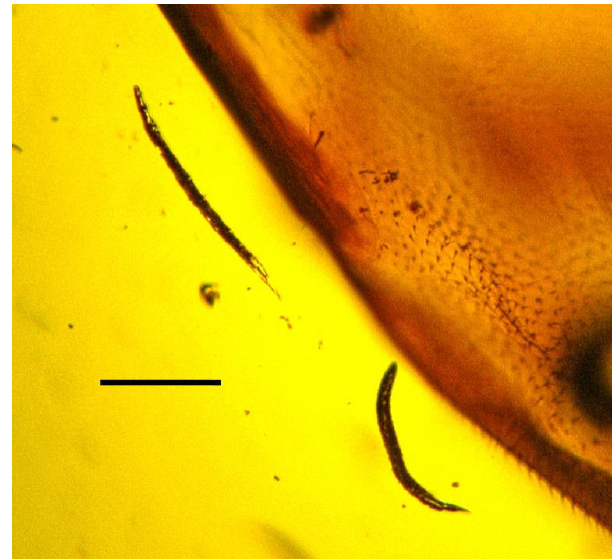
Figure 31. Two diplogastrid nematodes ( Scolytonema dominicana (Nematoda: Diplogastroidea) adjacent to a platypodine beetle (Coleoptera: Curculionidae: Platypodinae) in Dominican amber. Scale bar = 140 µm.